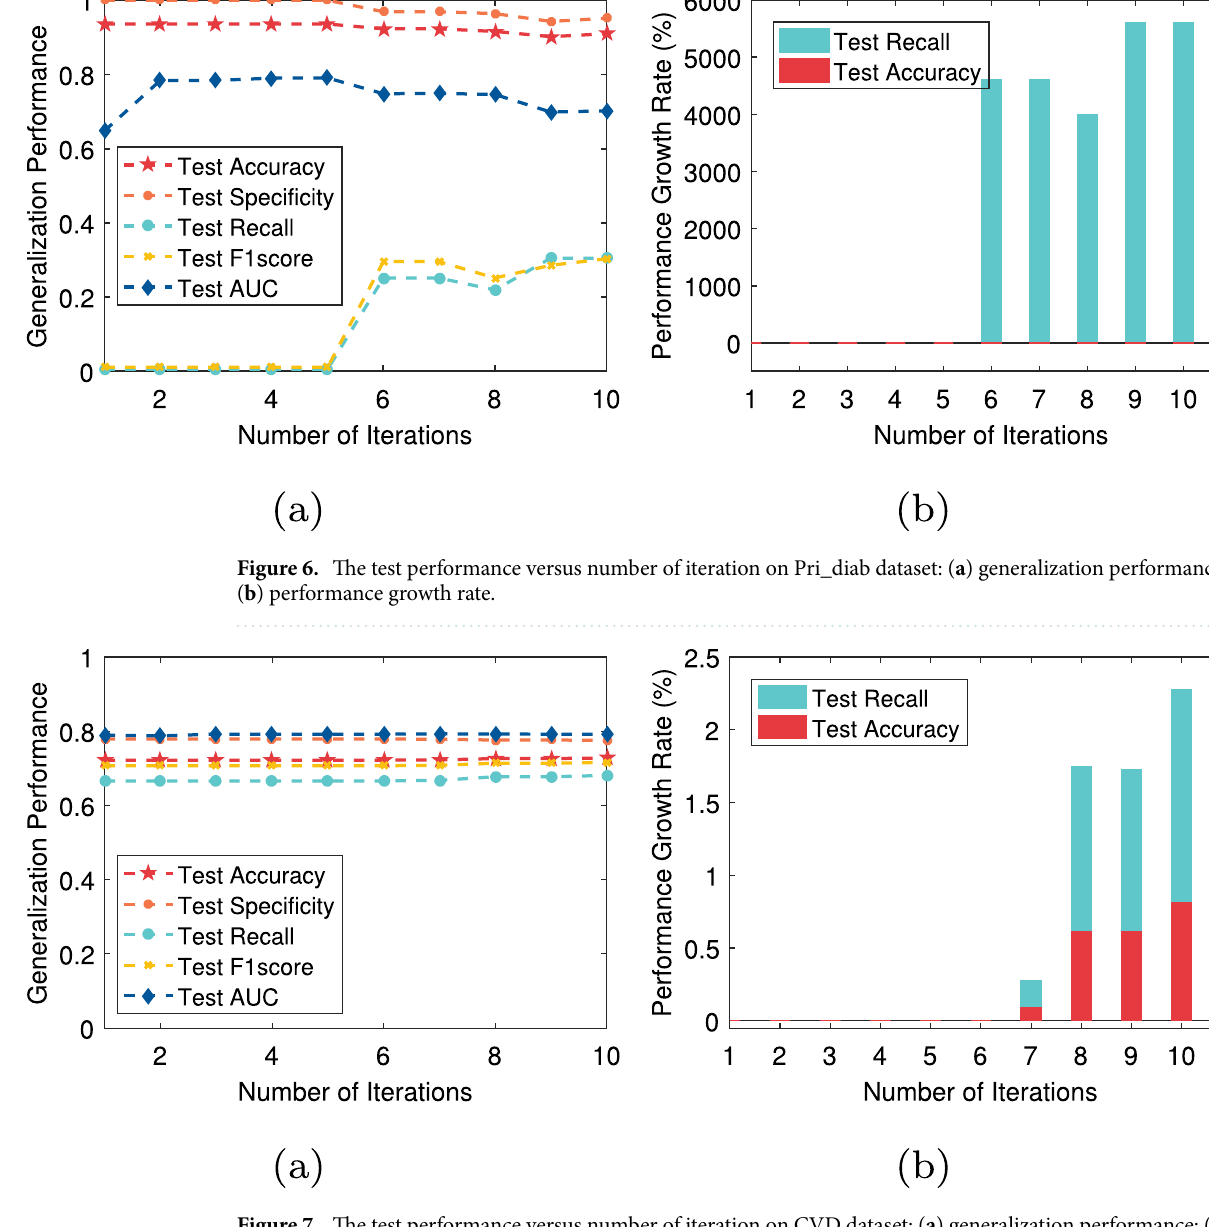
Figure 7. The test performance versus number of iteration on CVD dataset: ( a ) generalization performance; ( b ) performance growth